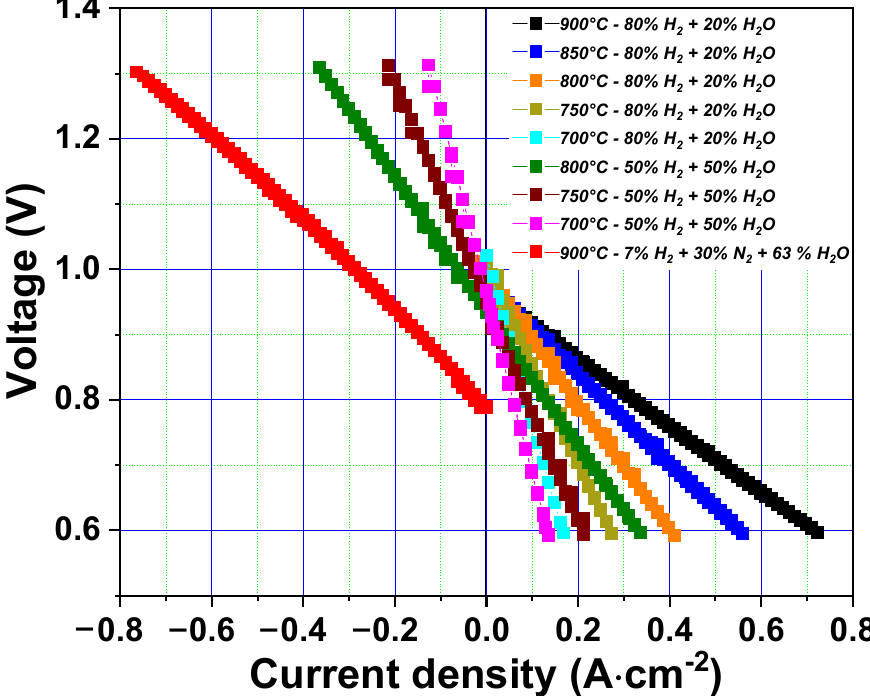
Figure 2. I-V curves for the 3Mo-3Au-Ni-GDC/8YSZ/GDC/LSCF single cell at different temperatures and fuel gas compositions.